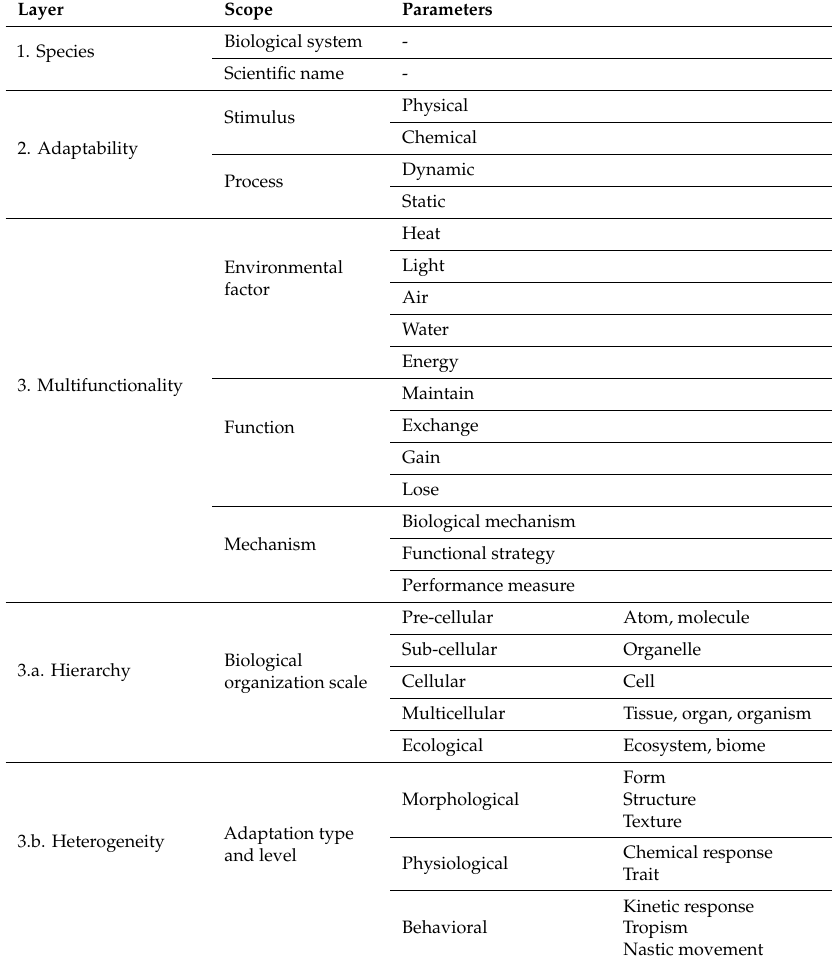
Table 2. The classification parameters of biological mechanisms for achieving multifunctionality in developing